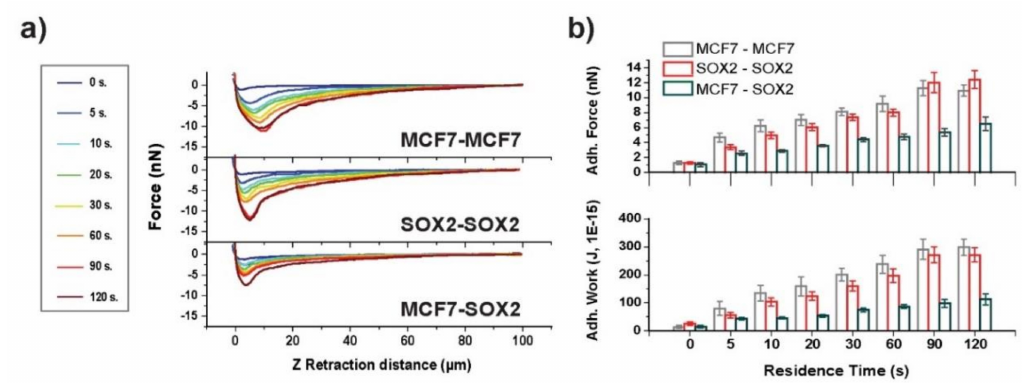
Figure 5. Contact time-dependent cell–cell interactions. ( a ) Contact time-dependent averaged force–distance plots for symmetric (MCF7–MCF7 and Sox2–Sox2), and the asymmetric (MCF7–Sox2) interactions for cells on top of fibronectin. ( b ) Adhesion force and work of adhesion values for the three systems under analysis.